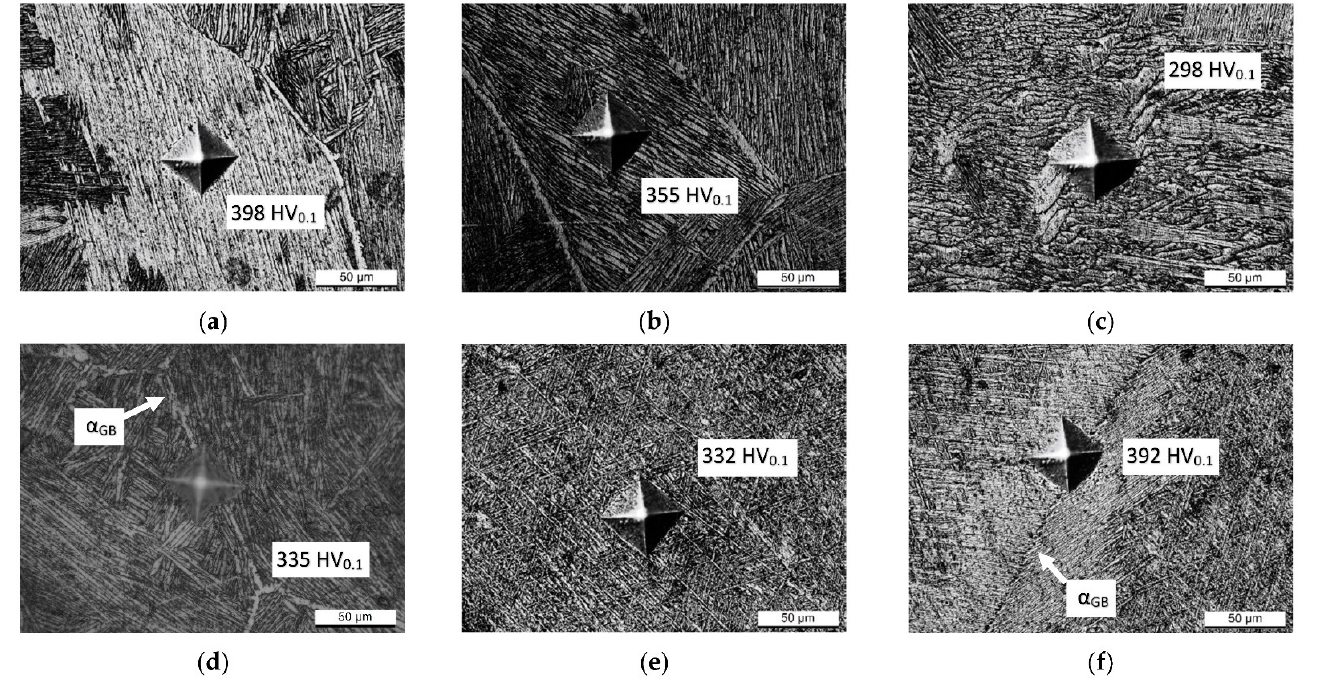
Figure 13. HV 0.1 indentations performed on different microstructures of the heat-treated 1050 °C/60 ′ : ( a – d ) 90° z -bar and ( e , f ) 90° z -tensile sample. ( a – d ) 90 ◦ ◦ z -bar and ( e , f ) 90 z -tensile